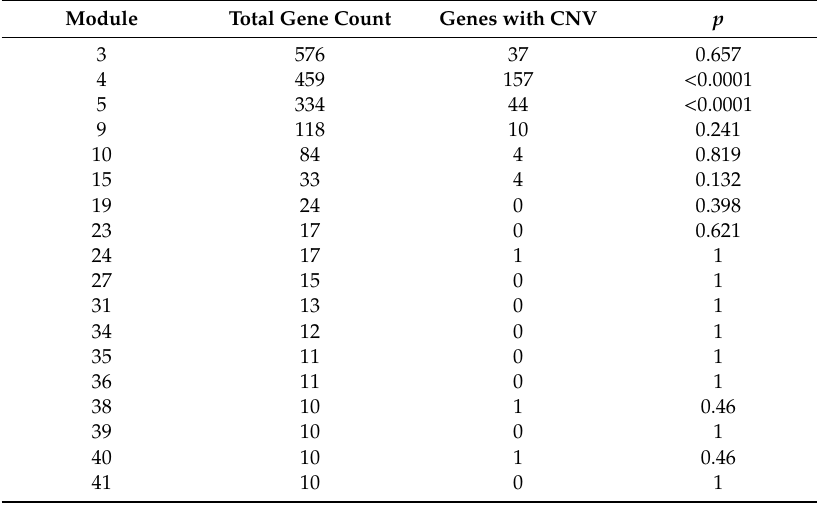
Table 5. Count overlap of genes with significant copy number variation and consensus lmQCM co-expression modules that showed statistically significant association with fusion